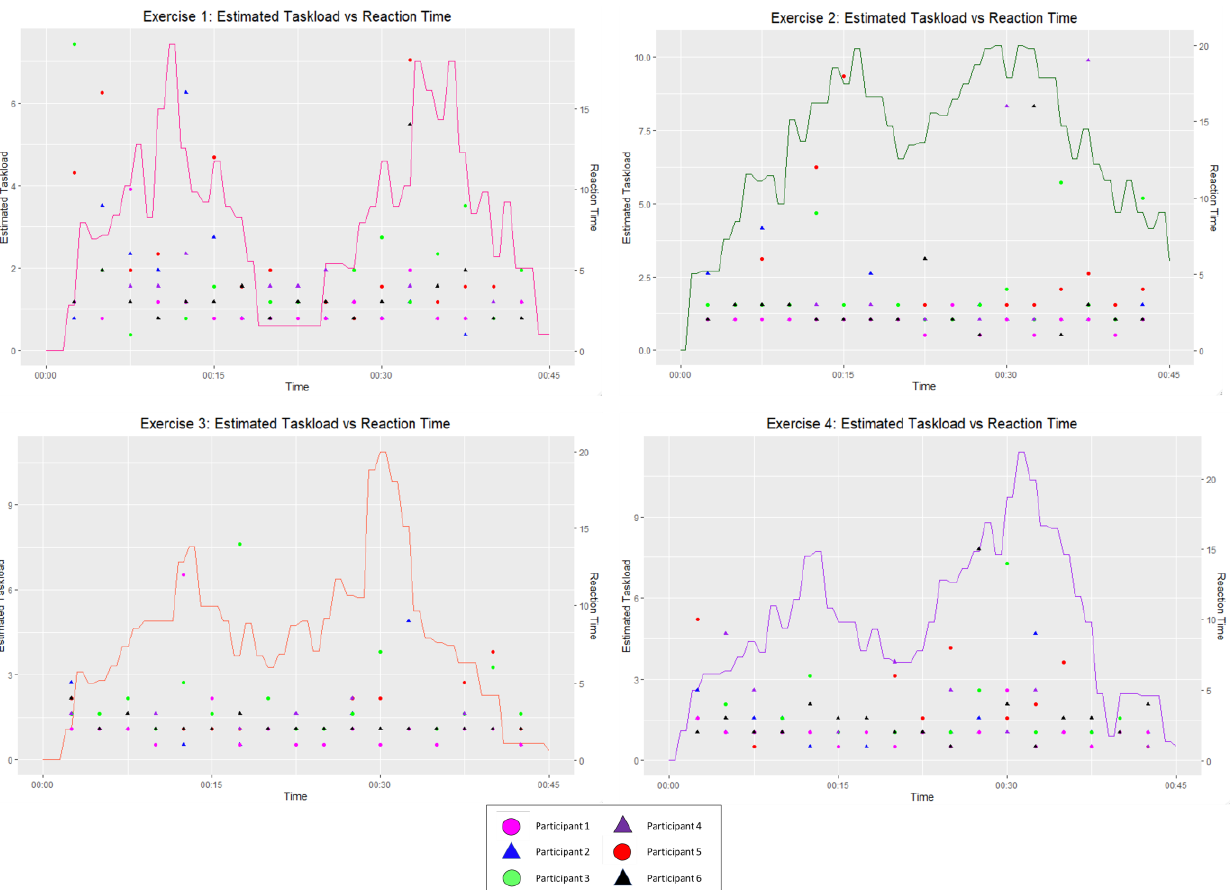
Figure 3. Combined representation of the designed taskload profile of the different exercises together with the reaction time values for the six participants. The first row of graphs presents the two simplest exercises, with Exercise 1 on the left and Exercise 2 on the right. The second row presents the data from Exercise 3 on the left and Exercise 4 on the right.